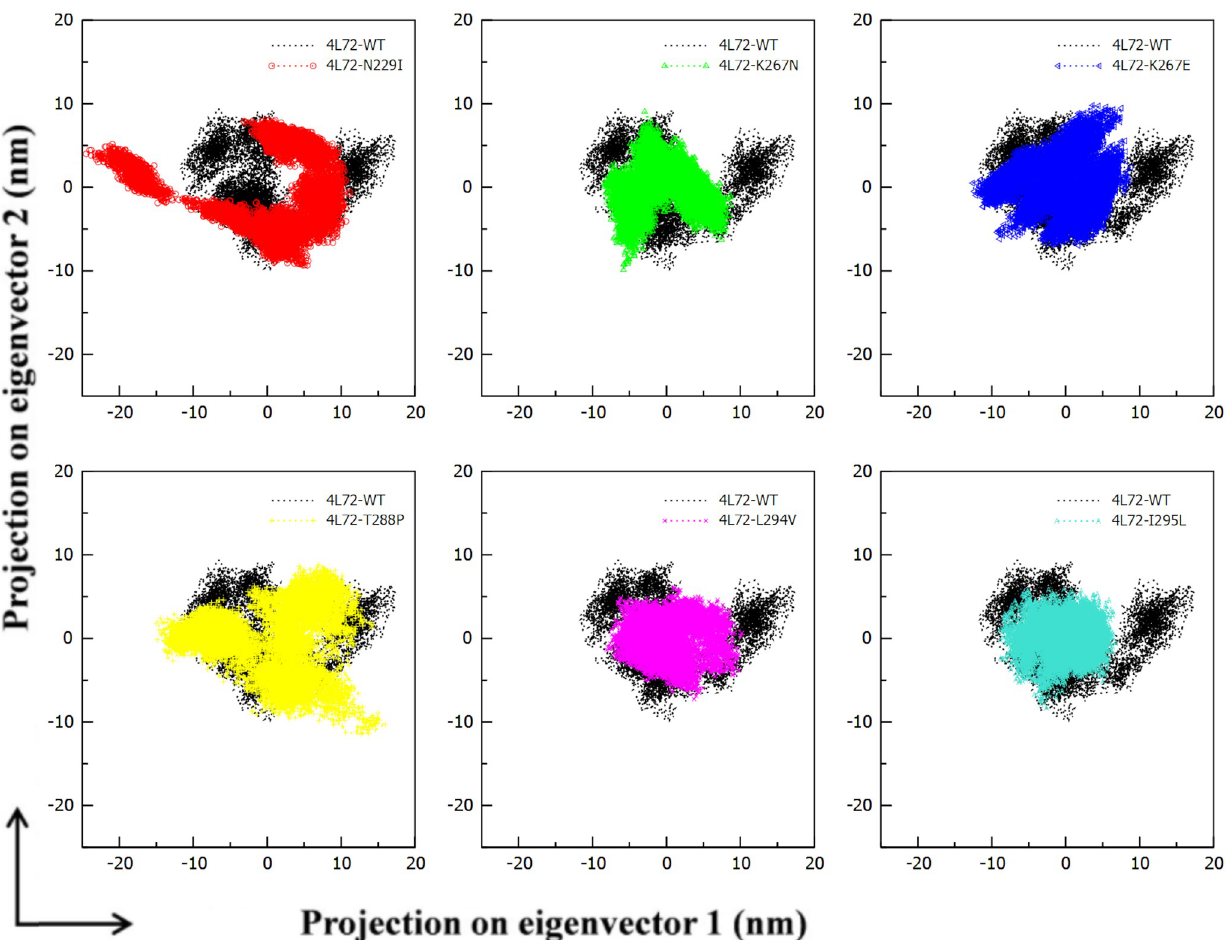
Fig 8. Principal component analysis 2-D projection MERS-CoV S1 RBD in complex with DPP4 wild and mutant type in phase space along first two principal eigenvectors. (a) RMSD 4L72-WT vs 4L72-N229I. (b) RMSD 4L72-WT vs 4L72-K267N. (c) RMSD 4L72-WT vs 4L72-K267E. (d) RMSD 4L72-WT vs 4L72-T288P. (e) RMSD 4L72-WT vs 4L72-L294V. (f) RMSD 4L72-WT vs